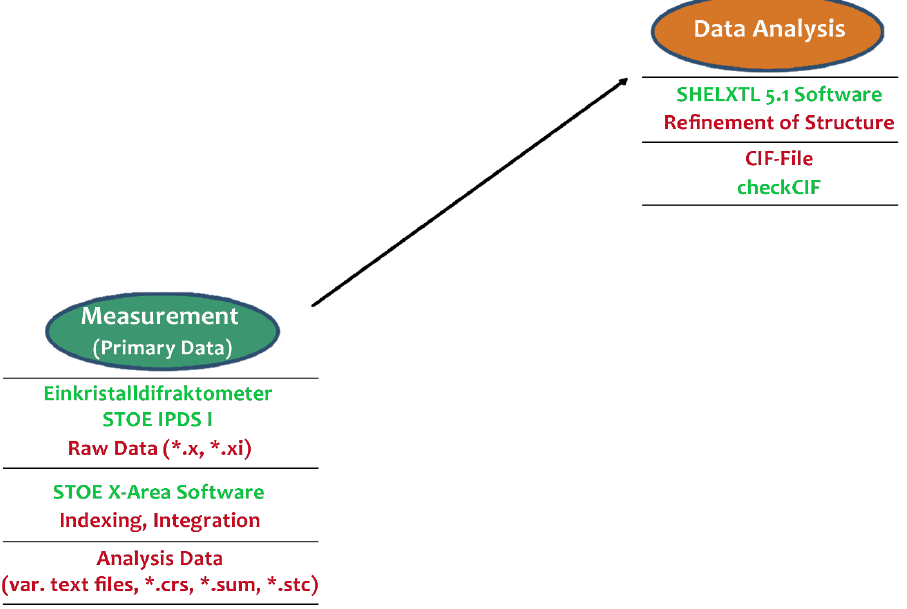
Figure 5. Provenance of published research data for defined publication (Detail: Step 1).